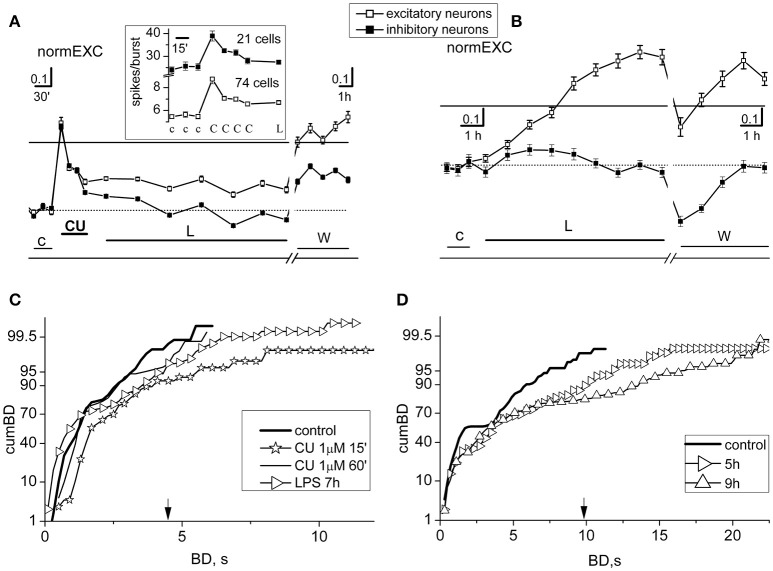
Short- and long-term effects of curcumin in networks treated with LPS. Results from two different experiments, performed in the same dish, with preconditioning or not-preconditioning with 1 μM curcumin (CU) (done 3 DIV later) before the application of LPS (3 μg/ml) are shown in (A,C) and (B,D), respectively. (A) Plots of normEXC in control (c), 1 μM CU (CU), LPS (L), and during washout (w). Inset: for the brief (~3 h) initial time segment in control, CU and L, plot of average number of spikes/burst observed in neurons of both clusters. The continuous line is the fixed threshold. Other details: the total number of spikes from excitatory (inhibitory, in parenthesis) neurons in control and CU (in bold): 304.2 ± 18, 568.5 ± 32 (481.9 ± 33, 764.7 ± 45.4); the total number of engaged excitatory (inhibitory, in parenthesis) neurons was in control: 52 ± 1.8, 63.8 ± 1.1 (17.8 ± 0.3, 19.3 ± 0.2). (B) In the same dish as in (A), but 3 DIV later, plots of normEXC in control (c), LPS (L) and during washout (w). The continuous line is the fixed threshold. (C) Plots of cumBD in different time regions of the experiment shown in (A). Data of cumBD are superimposed as explained in text. (D) Plots of superimposed cumBD curves in different time regions of the experiment shown in (B). Note that pre-conditioning with CU prevented the late, prolonged excitatory response to LPS. The vertical arrow indicates the fixed threshold.